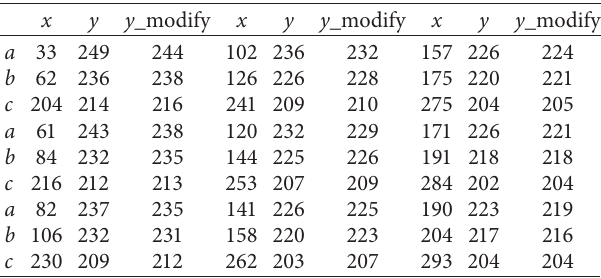
Figure 13: Coordinates and linear regression of 126 feature points. Table 2: Partial ordinates of feature points corrected.